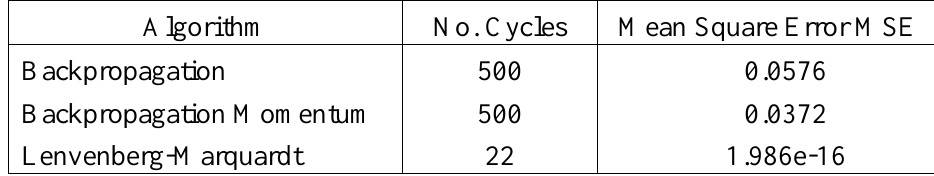
Table 1 . Training algorithms